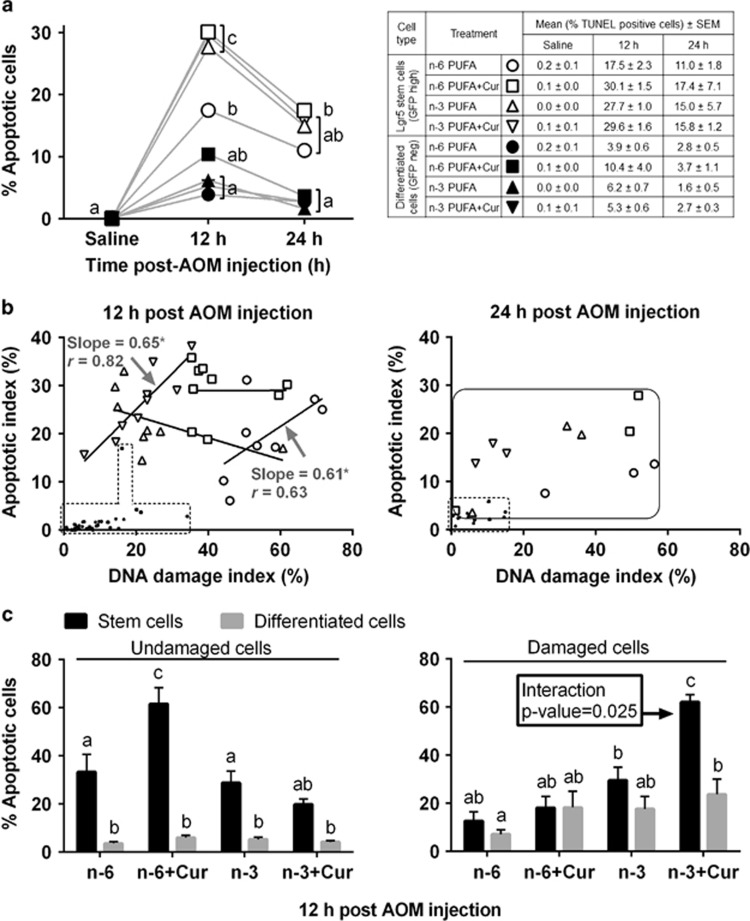
Effect of n-3 PUFA and curcumin on AOM-induced apoptosis in mouse colonic crypts at 12 and 24 h post AOM injection. (a) Comparison of TUNEL+ (apoptotic) stem and differentiated cells in the distal colon of saline, and 12 and 24 h post AOM-injected mice (left). Refer to Figure 1a legend for animal number and statistical details. Different letters indicate significant (P<0.05) differences between treatment groups at each time point. (b) Association between AOM-induced apoptotic cells and γH2AX+ cells in stem and differentiated cells at 12 h (left) and 24 h (right). Each point represents an individual animal and diets are labeled with different symbols as indicated in the Table in A. Slopes shown are found to be significantly different from 0 at a significant level of 0.05 (n-3 PUFA+Cur and n-6 PUFA stem cells, 12 h). Data from differentiated cells (12 and 24 h) and stem cells (24 h) are highlighted within the dotted lines and solid lines, respectively, instead of showing slope, as none of the slopes differed from zero. Linear regression was performed using GraphPad Prism 6.0. Values represent Pearson's correlation coefficients, r, ranges from −1 to +1. P-values were calculated using an F-test. Apoptotic index=no. of TUNEL+ stem or differentiated cells/total no. of stem or differentiated cells per crypt x100 at 12 and 24 h post AOM injection; damage index=no. of γH2AX+ stem or differentiated cells/total no. of stem or differentiated cells per crypt x100 at 12 and 24 h post AOM injection. (c) Percentage of non-targeted apoptosis (no. of TUNEL+ and γH2AX− stem or differentiated cells/total no. of γH2AX− stem or differentiated cells x100) at 12 h post AOM injection (left). Percentage of targeted apoptosis (no. of double-positive TUNEL+ and γH2AX+ stem or differentiated cells/total no. of γH2AX+ stem or differentiated cells x100) at 12 h post AOM injection (right). Refer to Figure 1a legend for animal numbers and statistics. Bars that do not share the same letter are significantly different (P<0.05). n-6, n-6 PUFA; n-6+Cur, n-6 PUFA+curcumin; n-3, n-3 PUFA; n-3+Cur, n-3 PUFA+curcumin